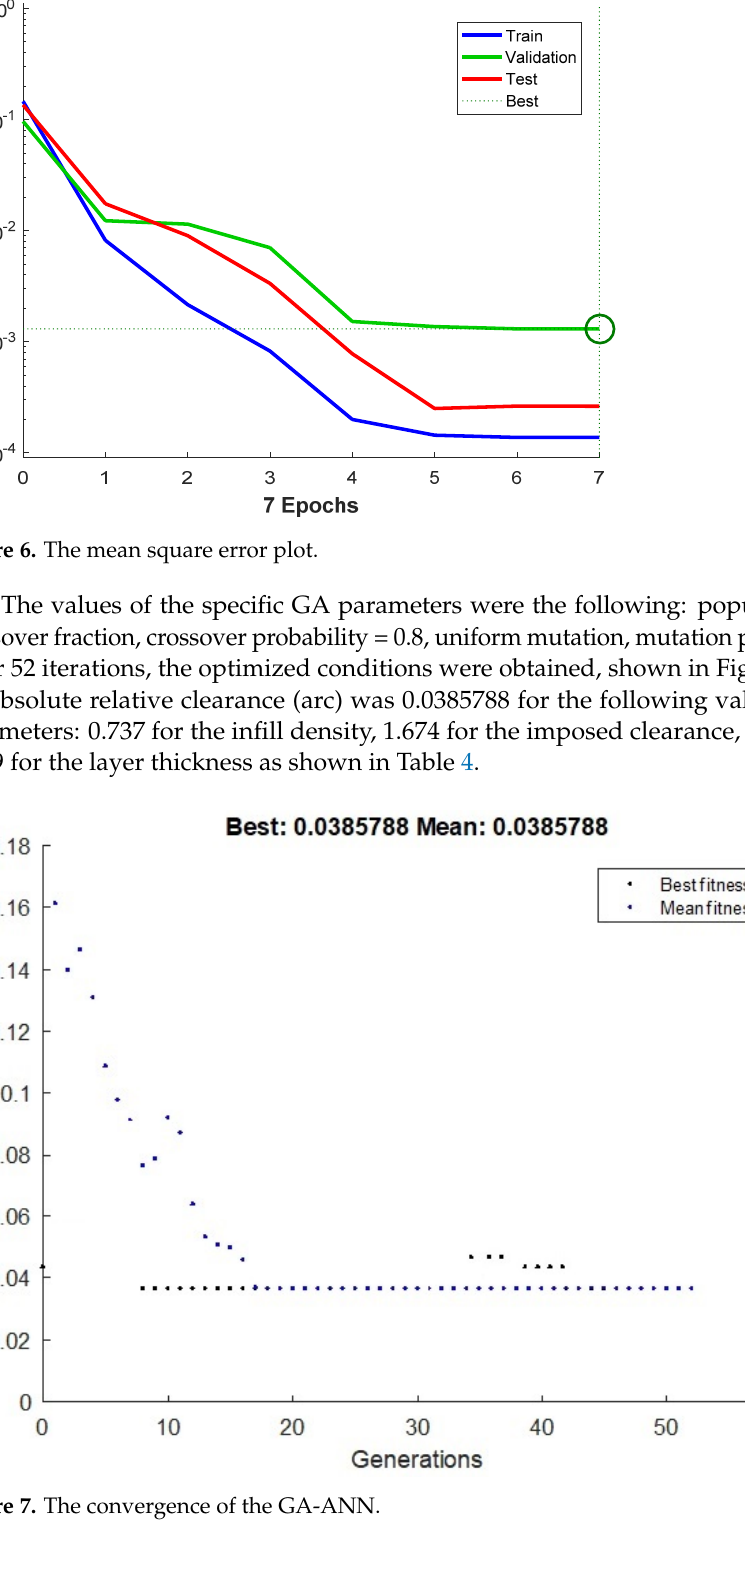
Figure 5. The ANN regression plot.